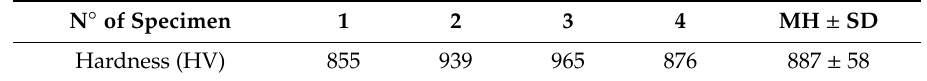
Table 6. Ultramicrohardness of the sintered prealloyed NiTi powder processed by FFF (1165 ◦ C, 5 h). N ◦ of